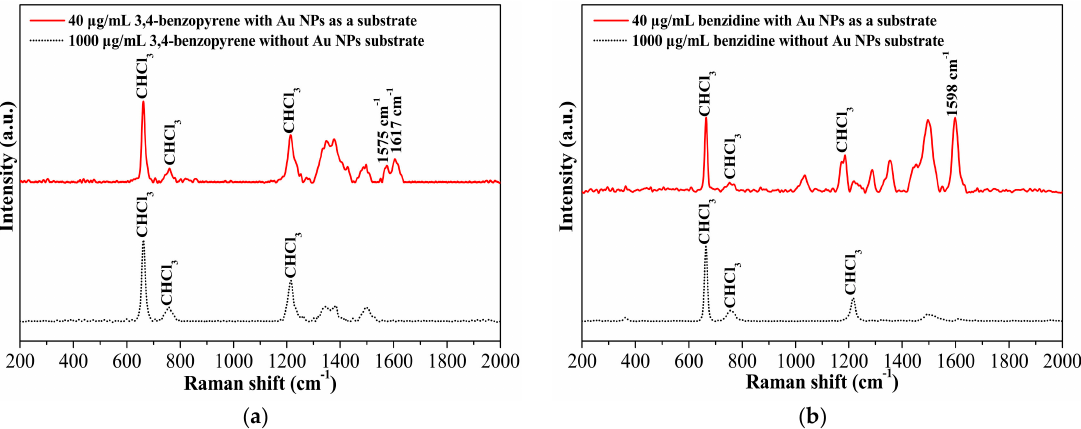
Figure 5. ( a ) Surface-enhanced Raman scattering (SERS) spectra of 3,4-benzopyrene with and without spherical gold nanoparticles (Au NPs) as a hydrophobic substrate; ( b ) SERS spectra of benzidine with and without Au NPs as a hydrophobic substrate.